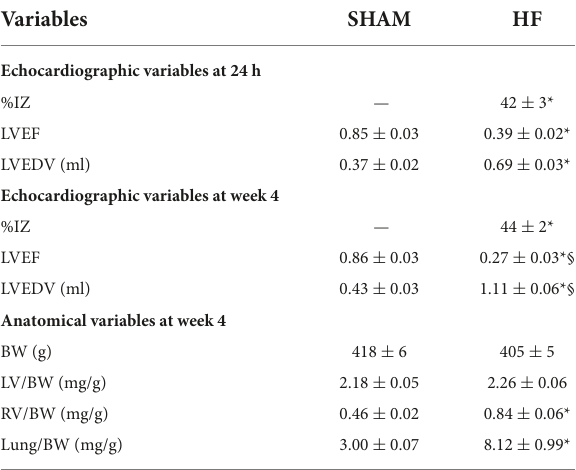
TABLE 2 Echocardiographic and anatomical measurements.